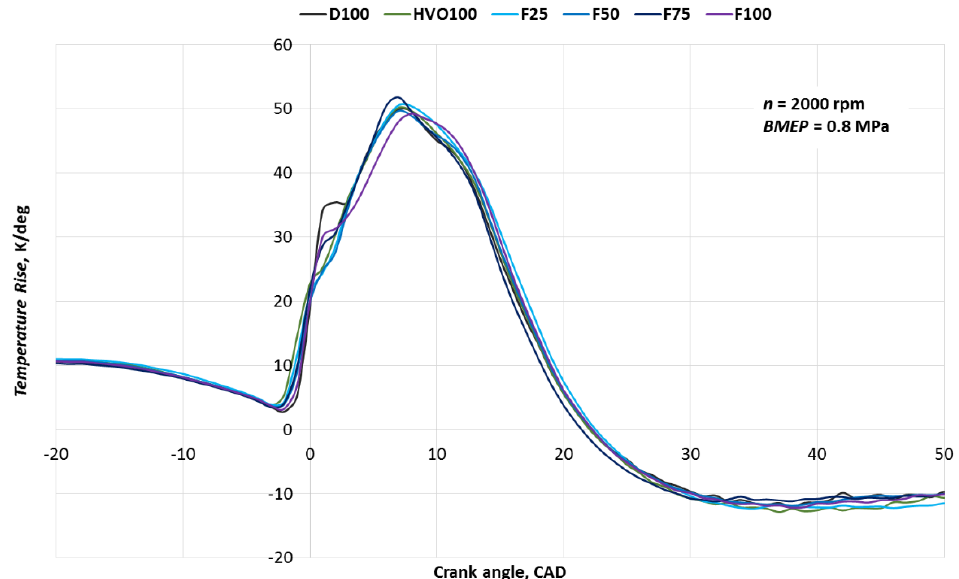
Figure 4. Dependence of the temperature rise in the cylinder using different fuels.